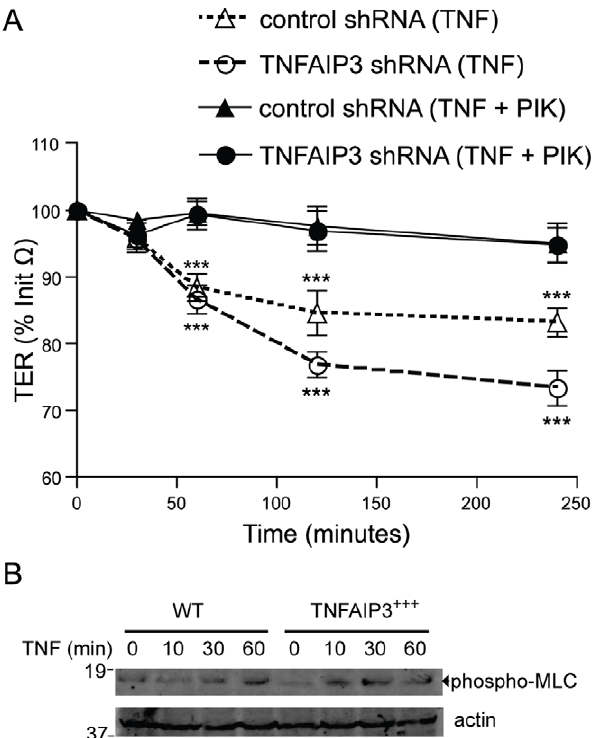
Figure 6. TNFAIP3 regulates an MLCK-dependent signal, but does not control MLCK activity. (A) TER measurements of stably transduced pools of cells expressing scrambled shRNA (control shRNA; triangles) or TNFAIP3 shRNA (circles) were treated with TNF alone (10 ng/ml; open symbols) or TNF plus the cell permeant MLCK inhibitor PIK (200 m M; closed symbols). Values represent percentage of initial resistance measurements (% Init V ). (***p , 0.001; TNF vs. TNF + PIK treated) (B) Immunoblot of phospho-MLC levels using whole cell lysates from GFP transduced (WT), or GFP together with TNFAIP3 transduced (TNFAIP3 +++ ) cells treated with TNF (10 ng/ml) for the indicated times minutes.